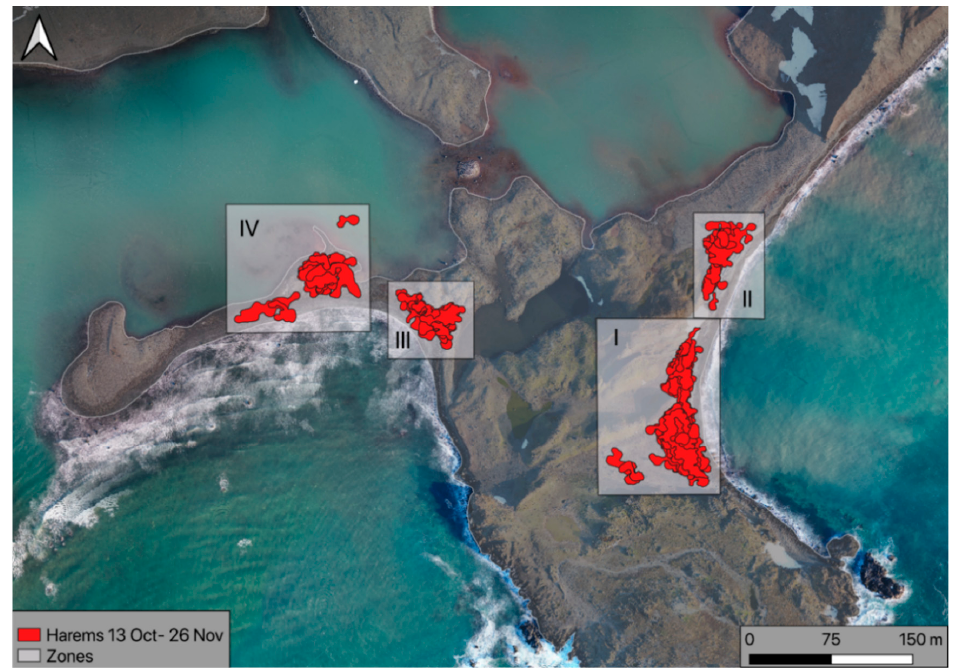
Figure 5. Division of harems into zones at Patelnia Point.